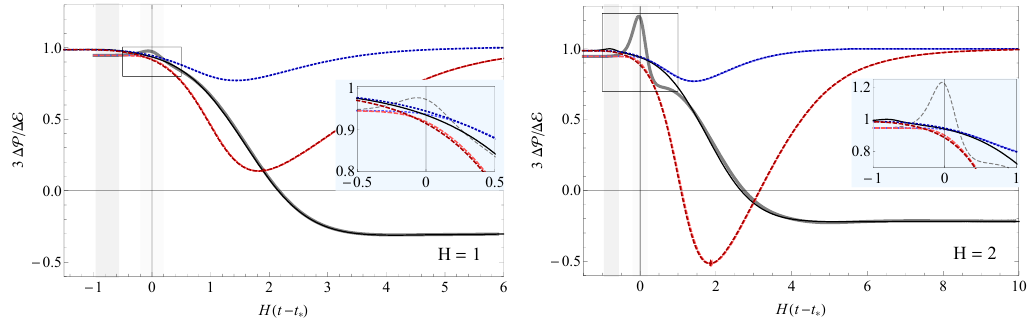
Figure 6 . For H = 1 (left) and H = 2 (right) we compare the result of figure 5 with an equivalent run that starts with an energy density 19.3 times higher. The original run is displayed in lighter col- ors and gray, whereas the high-energy run is displayed in dark colors and black. The high-energy run is shifted by an extra time of H ∆ t = 0 . 76 for both figures, in order to guarantee that the energy evo- lution of both simulations agree at late times. After this shift in time there is virtually no difference between the results, except small differences before the quenches (displayed gray and dark